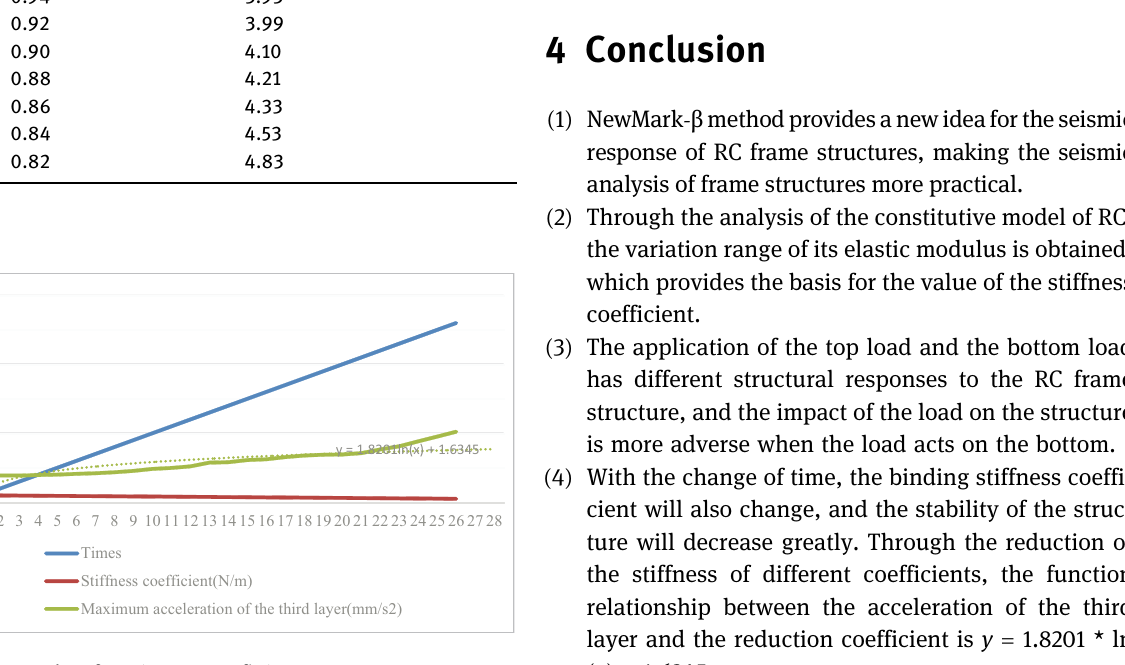
Figure 8: Results of 26 times curve fi tting.